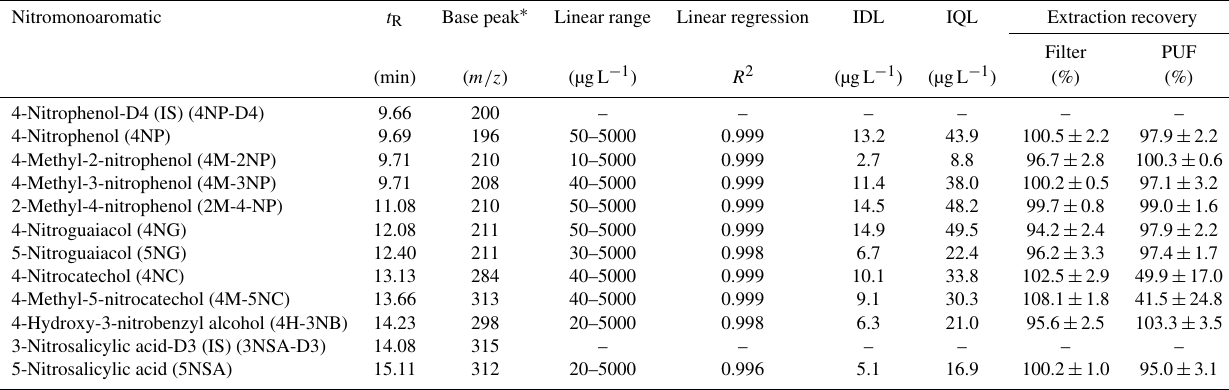
Table 1. Method performance parameters for nitromonoaromatics, including GC retention time ( t R ) , instrument detection limit (IDL), in- strument quantitation limit (IQL), and mean extraction recoveries ( ± 1 standard deviation for n = 3). Nitromonoaromatic t R Base peak ∗ Linear range Linear regression IDL IQL Extraction